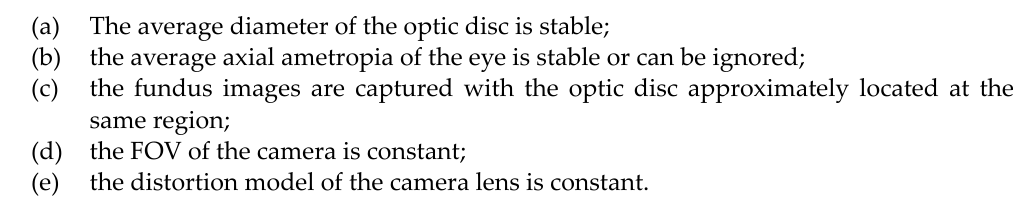
Figure 3. The workflow of estimating pixel pitch of fundus image.